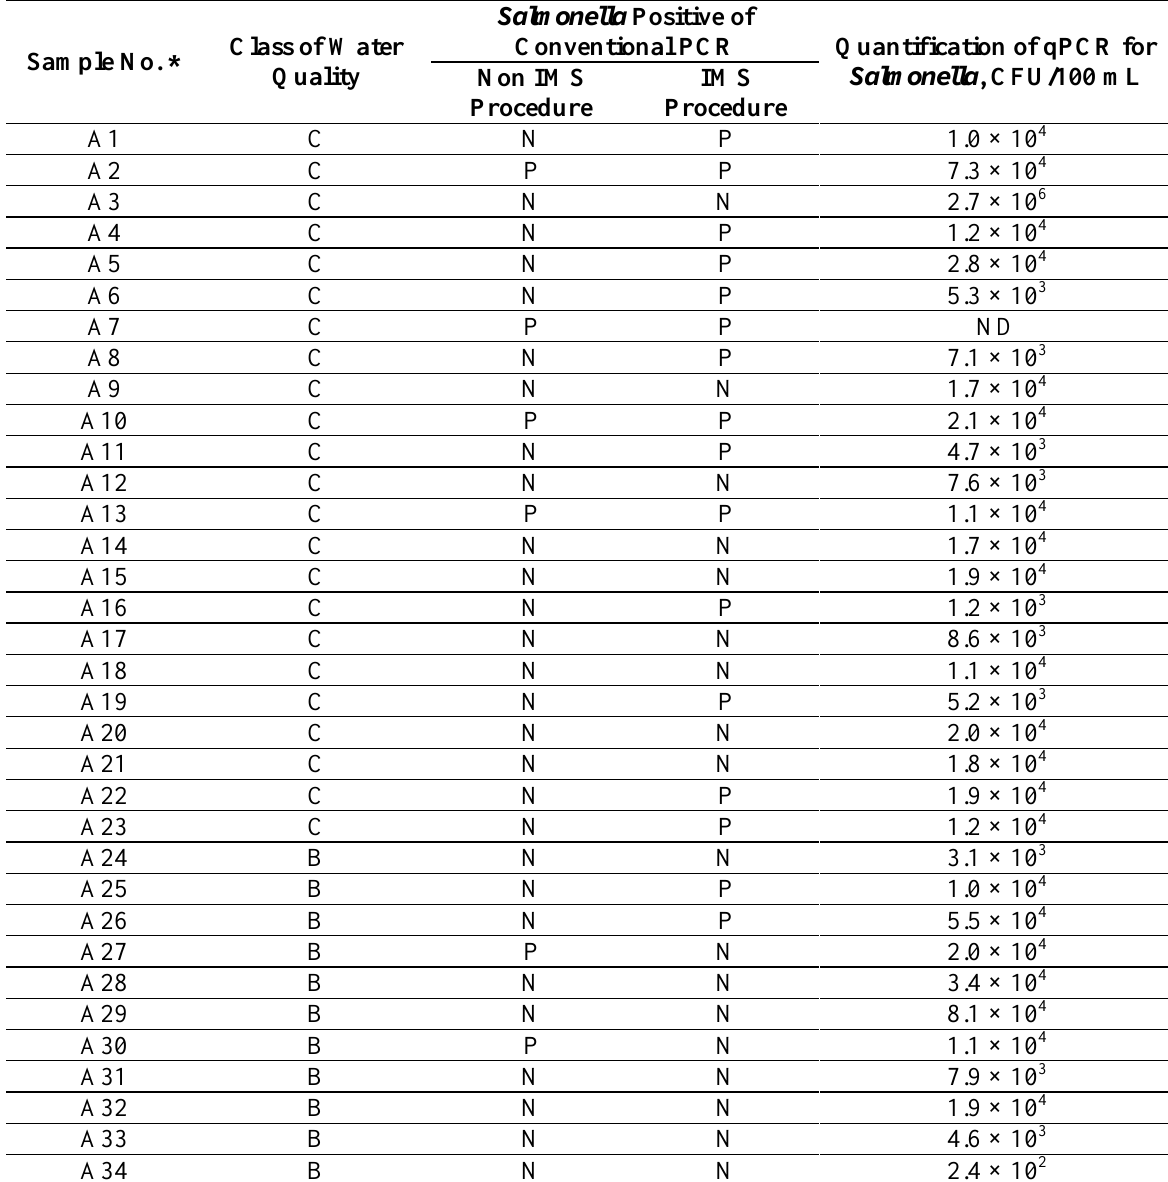
Table 1. The occurrence and quantification for Salmonella using PCR with and without IMS process. Sample No.